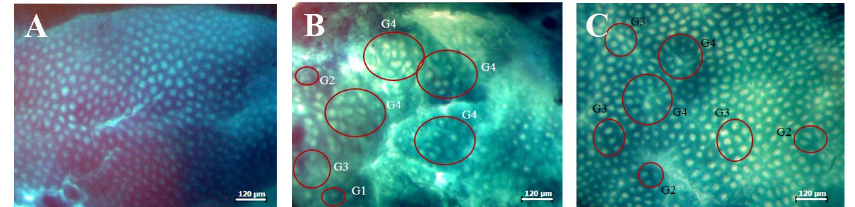
FIGURE 1 - Aberrant crypt foci with different grades in the longitudinal sections of the distal colon region stained with Toluidine blue. A: normal, the distribution of crypts is regular and uniform; B and C: Aberrant crypt foci with grades 1 (G1), 2 (G2), 3 (G3) and 4 (G4).